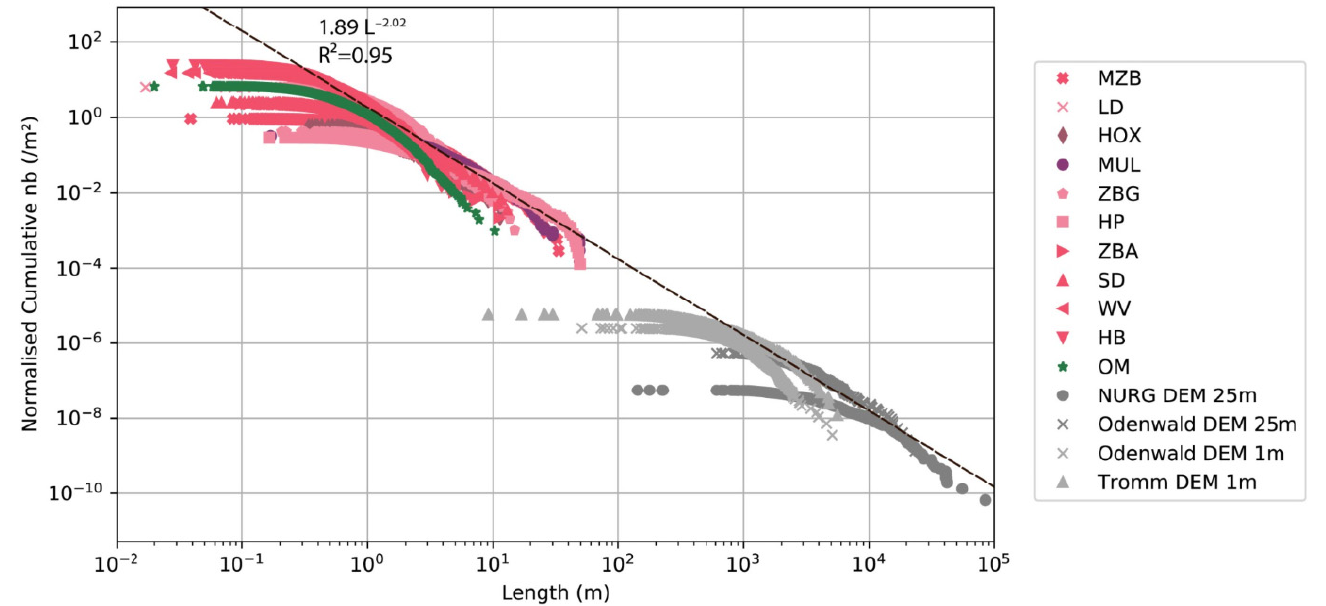
Figure 10. Cumulative length distribution and orientation roses for the Odenwald, compared with trends reported in the Schwarzwald and the Vosges (Bertrand et al., 2018; Meixner et al., 2016, 2018).